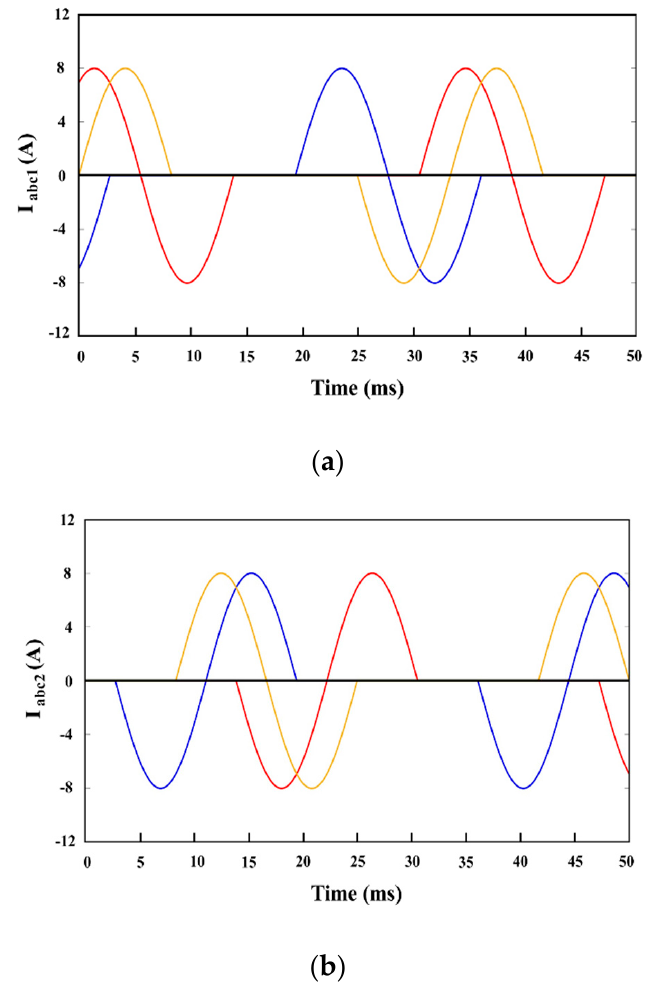
Figure 4. Output three-phase current of ( a ) inverter-1 and ( b ) inverter-2.